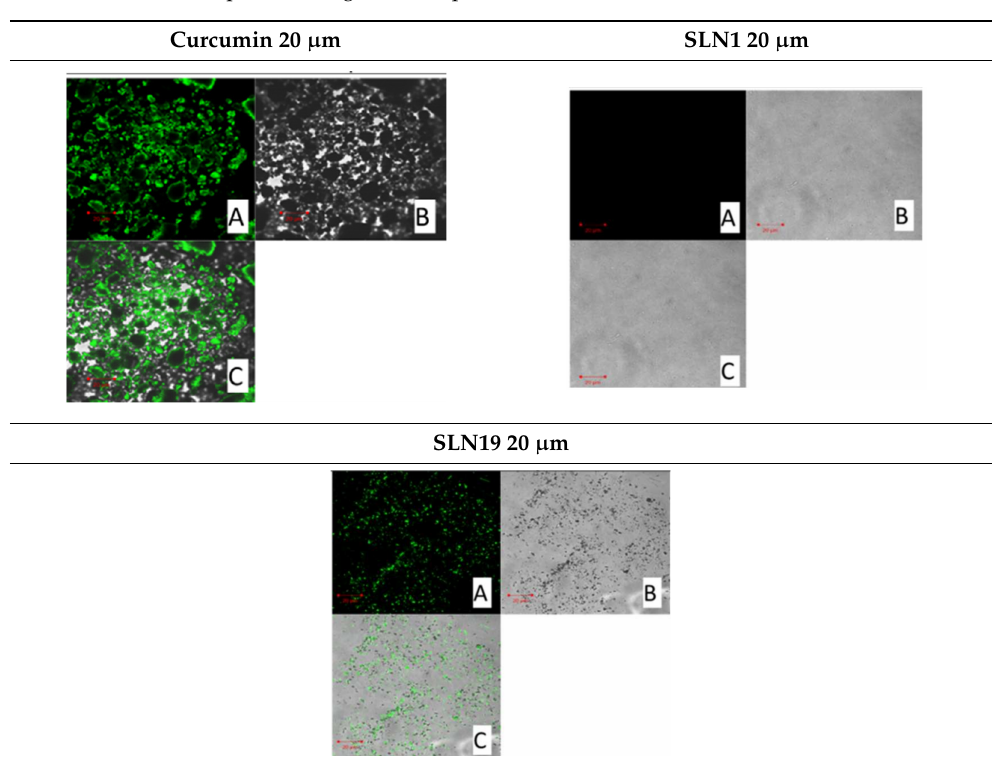
Table 4. Confocal microscope, i.e., (A) fluorescence, (B) bright-field, and (C) superimposed images of curcumin (left side, top), SLN1 (right side, top), and SLN19 (bottom) materials.